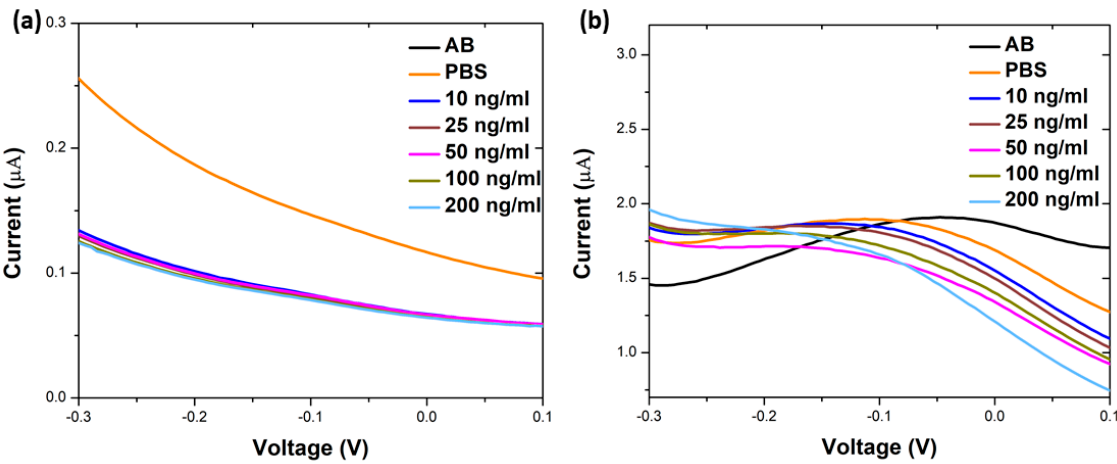
Figure 5. Control experiments pulse voltammetry (DPV) results for A β (1-42) peptide sensors made from amino- functionalised substrates using different numbers of reduction scans carried out by ( a ) absence of amine and ( b ) negligible amount of amine are